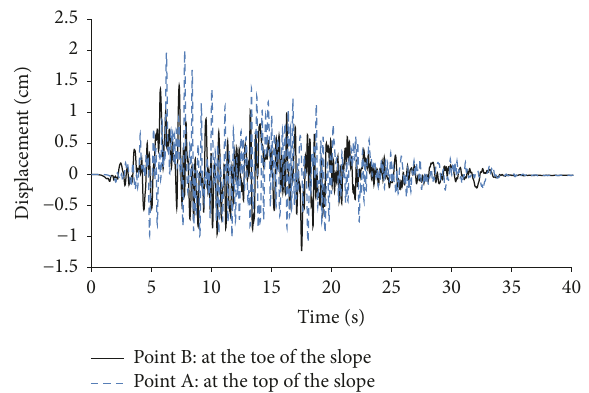
Figure 11: The comparing of the horizontal displacement curve of different observation